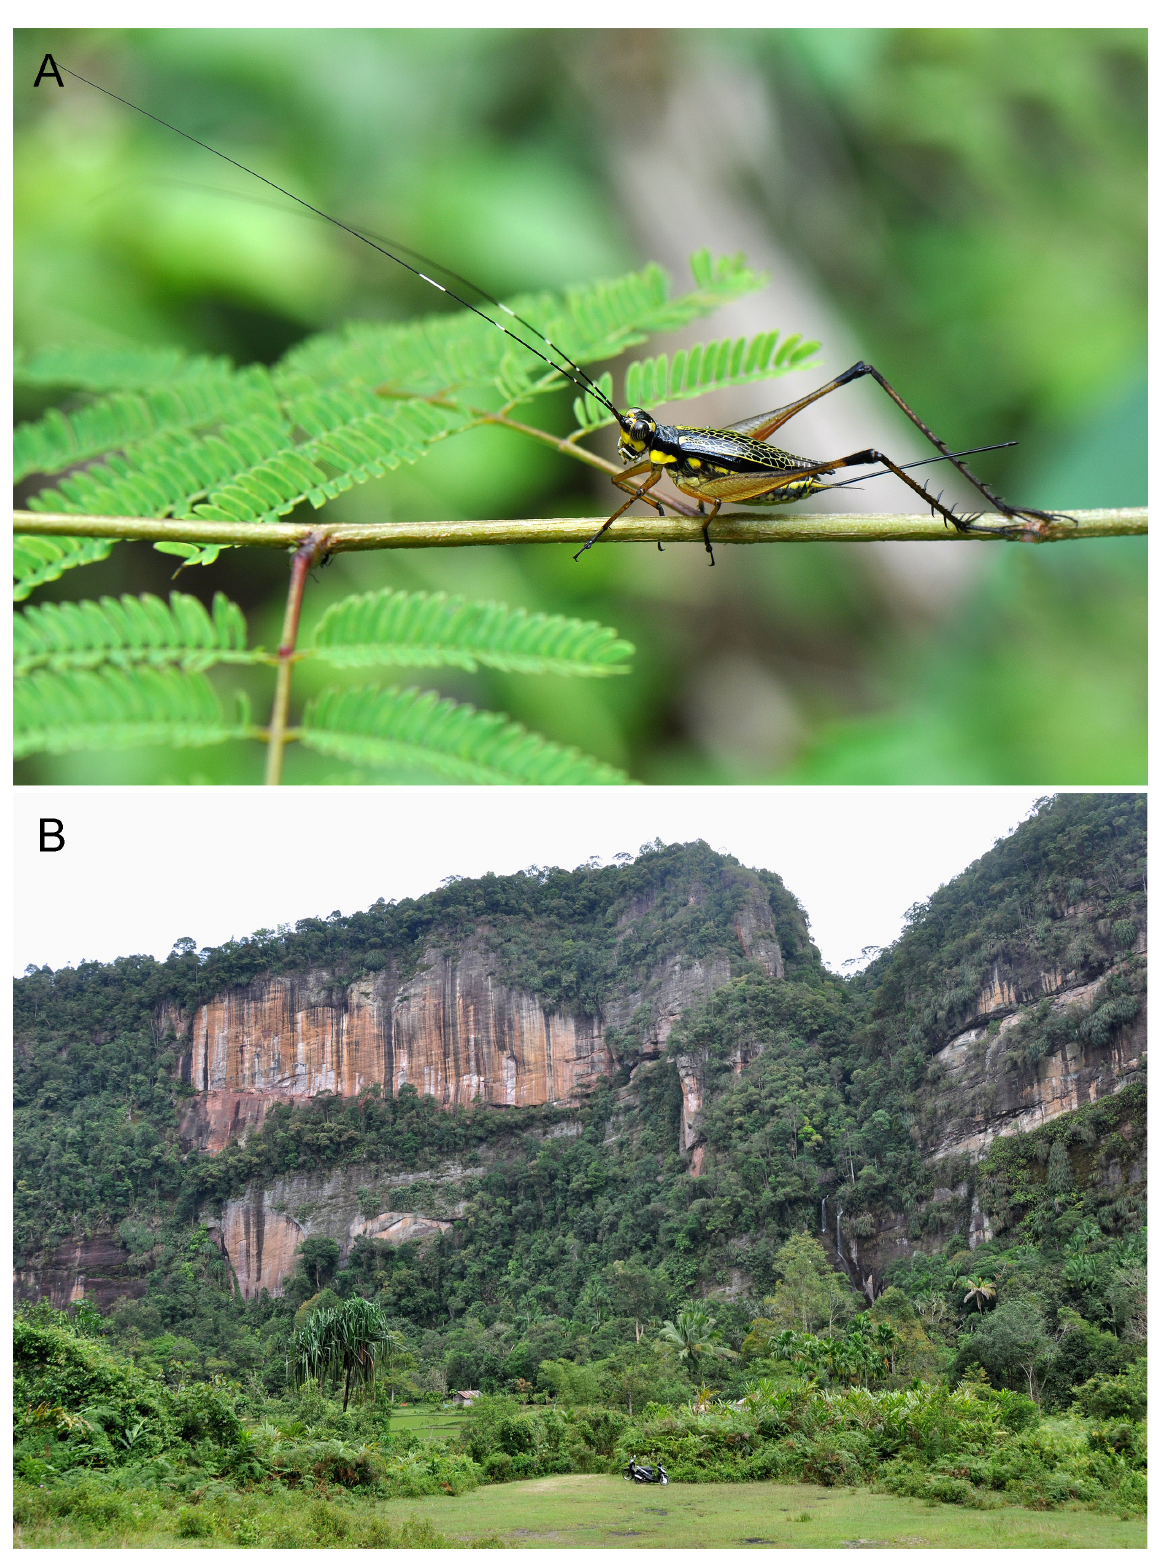
Fig. 2. A . Nisitrus insignis Saussure, 1878, adult ♀. B . Natural habitat of a typical Nisitrus Saussure, 1878, Lima Puluh Koto, Sumatra, Indonesia. Photograph source and credits: iNaturalist; Dries Nys and Marion